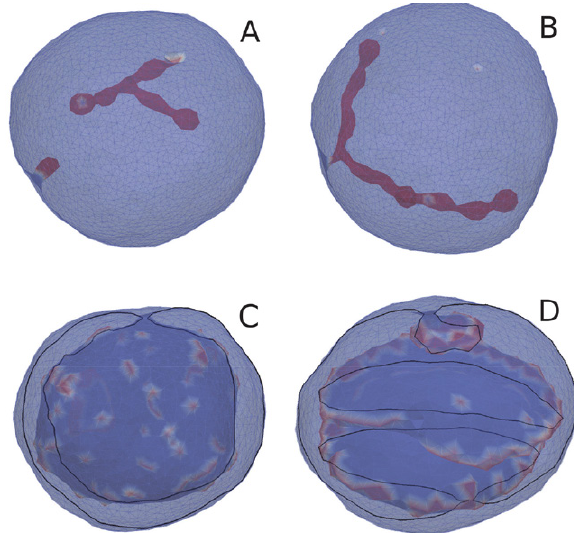
Figure 3 depend on the inclusion concentration, the inclu- sion intrinsic curvature, the strength of the direct attrac- tive interaction between inclusions and on the active forc- es exerted by the inclusions.